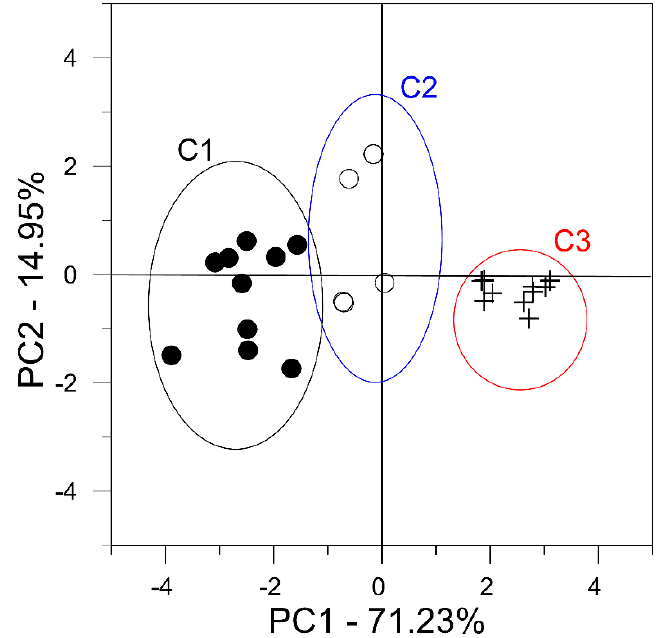
Figure 3. Scatterplot of the soil samples on the plane of the first two principal components resulting from the application of PCA to EOX and PCB contents. C1, C2, and C3 identify the three groups of soil samples resulting from the application of the Cluster analysis to the scores of the first two main